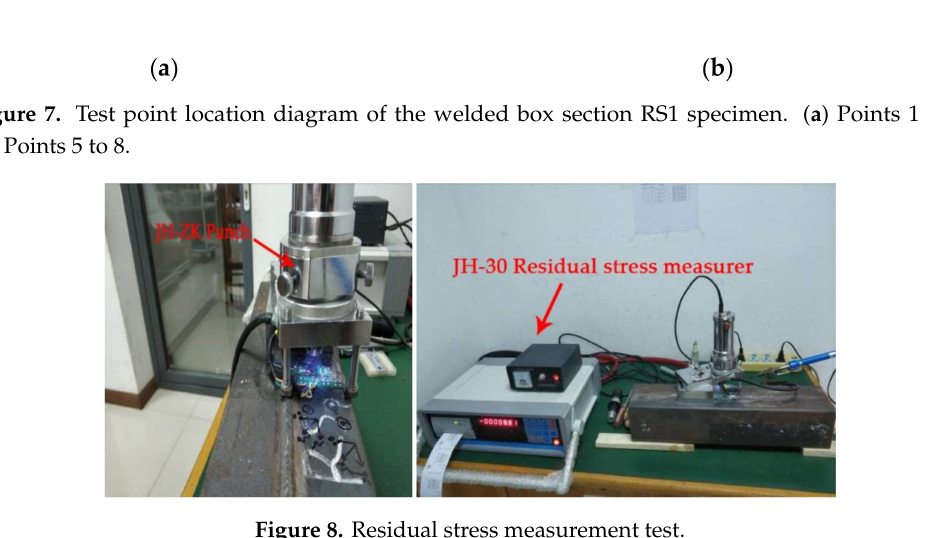
Figure 8. Residual stress measurement test. Table 5. Residual stress values of each test point